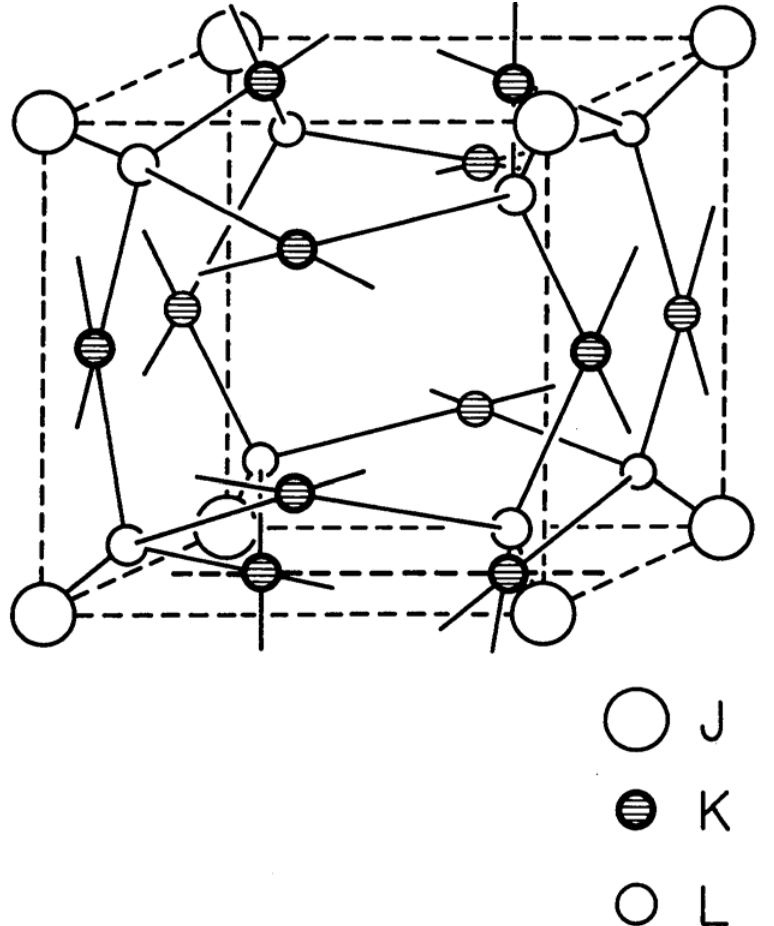
Figure 2. Jubilite